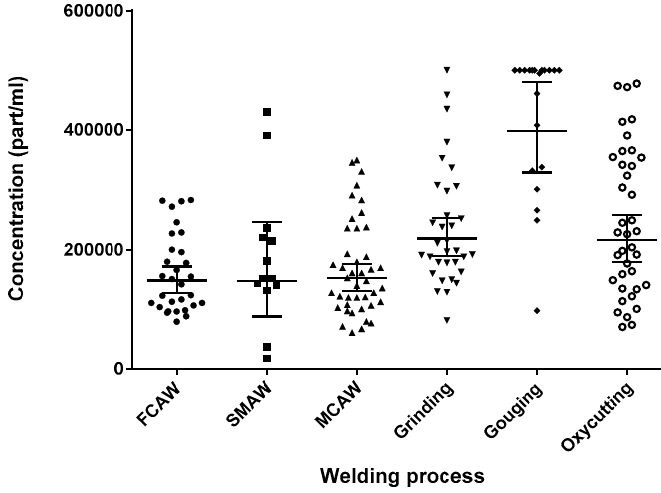
Figure 4. Manual task breathing zone grab samples; FCAW ( n = 30), SMAW ( n = 13), MCAW ( n = 42), grinding ( n = 33), gouging ( n = 20), and oxycutting ( n = 38). FCAW: flux cored arc welding; SMAW: shielded metal arc welding; MCAW: metal cored arc welding.